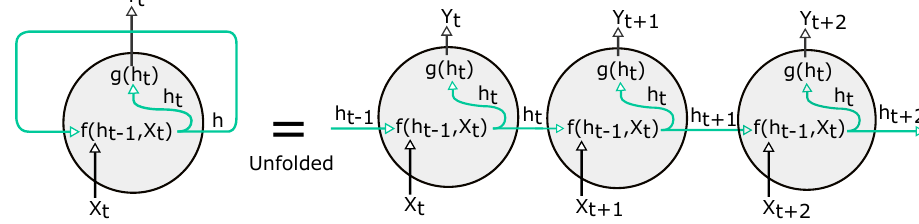
Figure 6. Folded and unfolded regular RNN.